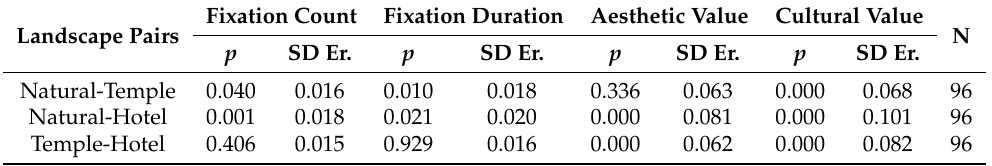
Table 3. Least significant difference pairwise comparison of three landscapes.